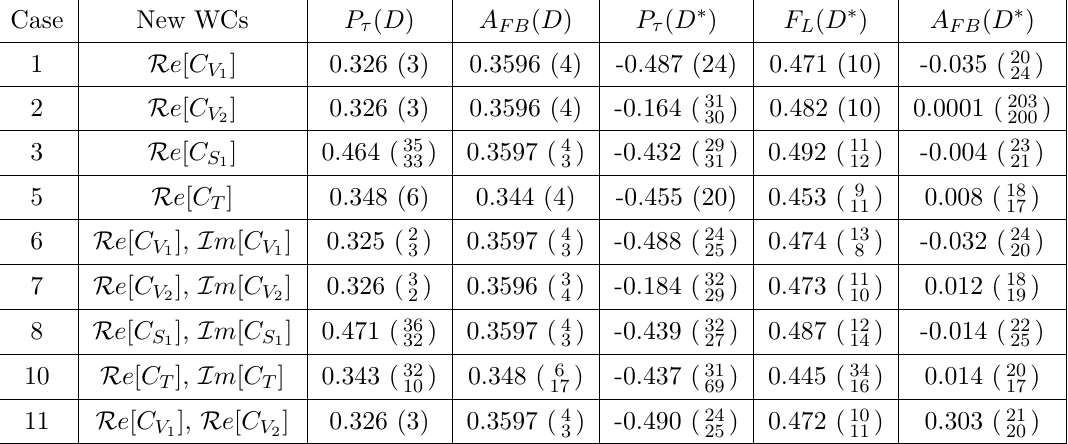
Table 10. Predictions for various angular observables for the allowed new physics scenarios in table 8 using the NP (cid:12)t to all the experimental